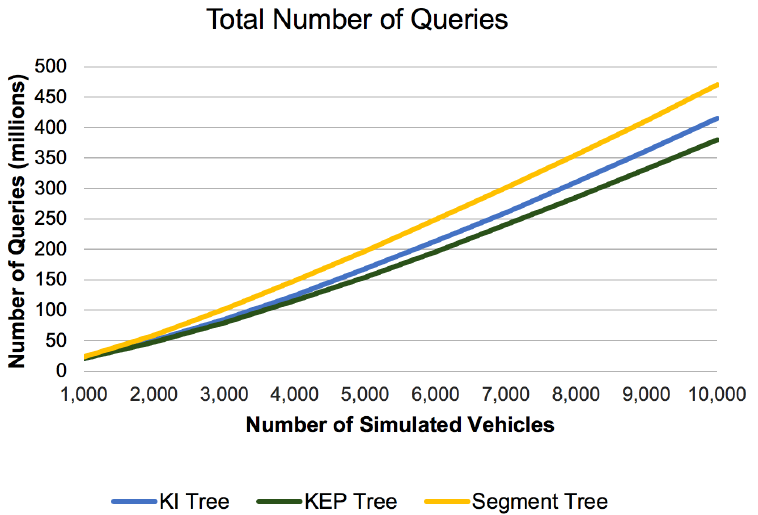
Figure 18. Total Number of Queries